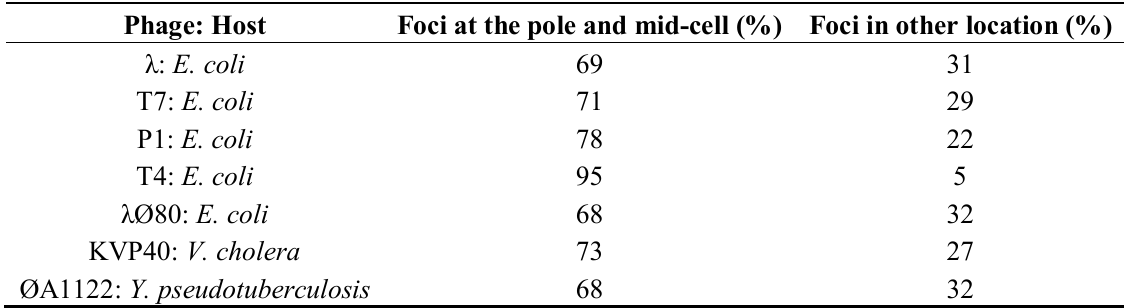
Table 2. Localization of different phages on cell surface. QDots label phages are compared for their localization on cell surface (Adopted and modified from